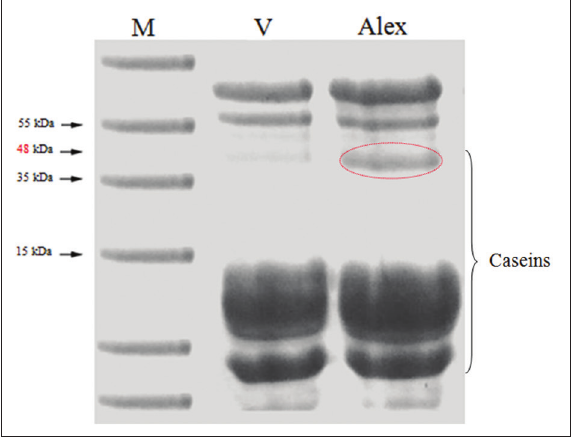
Figure-1: Sodium dodecyl sulfate-polyacrylamide gel electrophoresis separates milk proteins of V-line (V) and Alexandria (Alex) line.